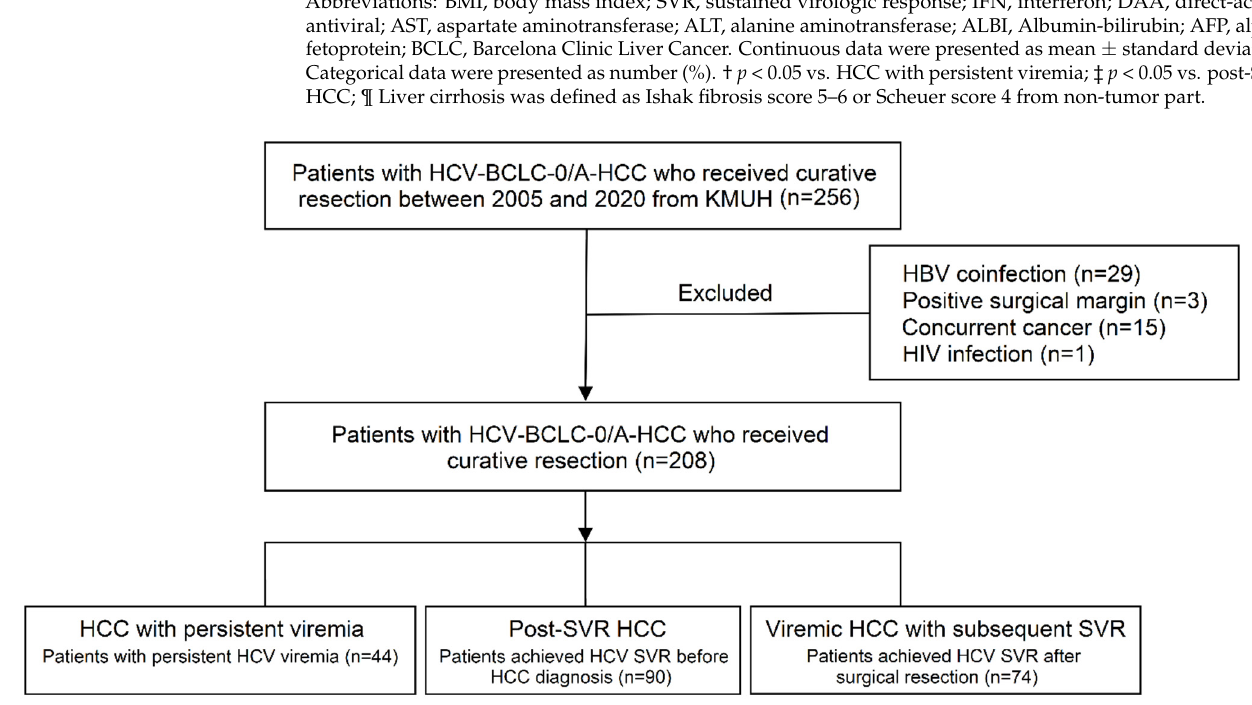
Figure 1. Flow chart of the study. Table 1. Baseline characteristics of the 208 patients with early-stage HCV-related HCC.